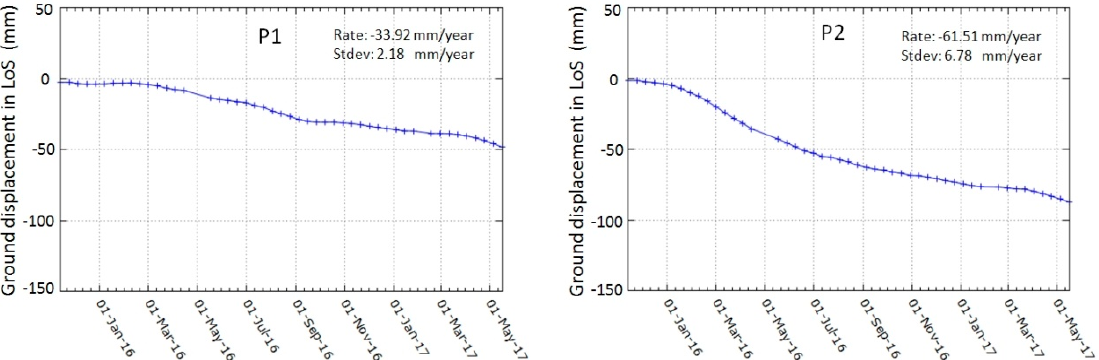
Figure 21. PSI results of the ground displacement in LoS of the points P1 and P2 in the auxiliary dikes of the sector D.